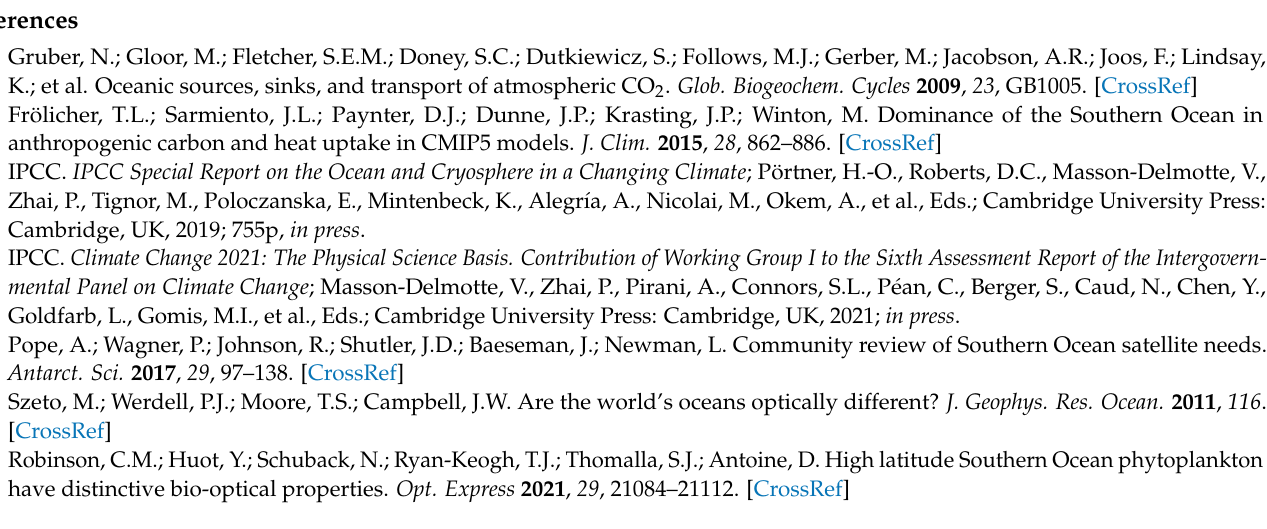
Figure S3: Relationship between the fucoxanthin-to-Chl- a ratio and the percent